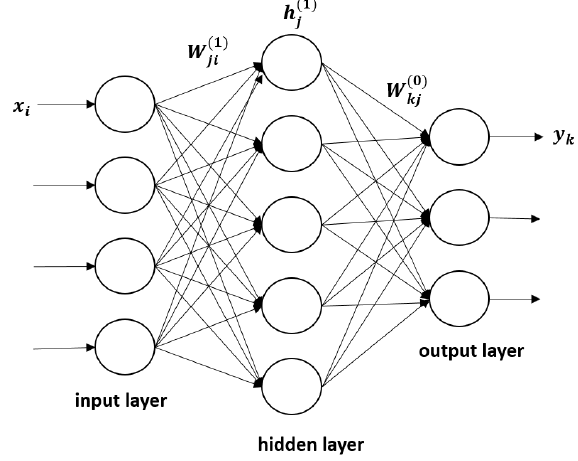
Figure 1. One-layer neural